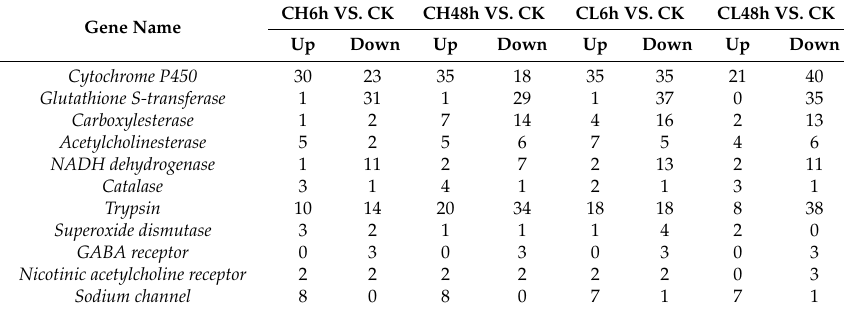
Table 4. DEUs related to insecticide metabolism. Up: Up-regulated expression; Down: Down-regulated expression. Up- or down-regulation indicates that the unigene’s FPKM value for insecticide-treated samples is two times more or 0.5 times less than that in